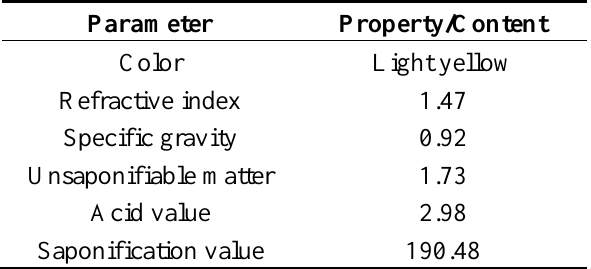
Table 1. Physico-chemical parameters of the seed oil of I. hederacea